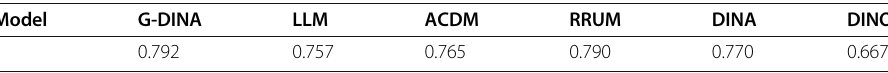
Table 7 Test level accuracy